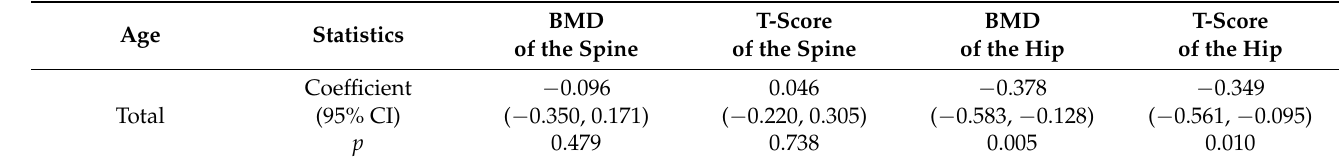
Table 4. Values of Spearman’s rank correlation coefficient ( ρ ) and 95% CI between age and values of BMD (g/cm 2 ) and T-score of the spine and hip in experimental OA.